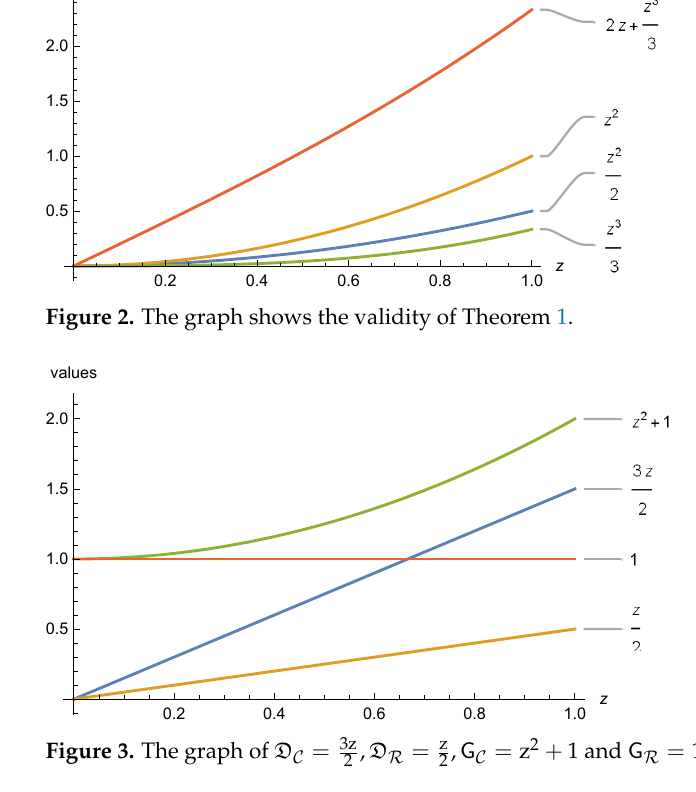
Figure 3. The graph of D C = 3z